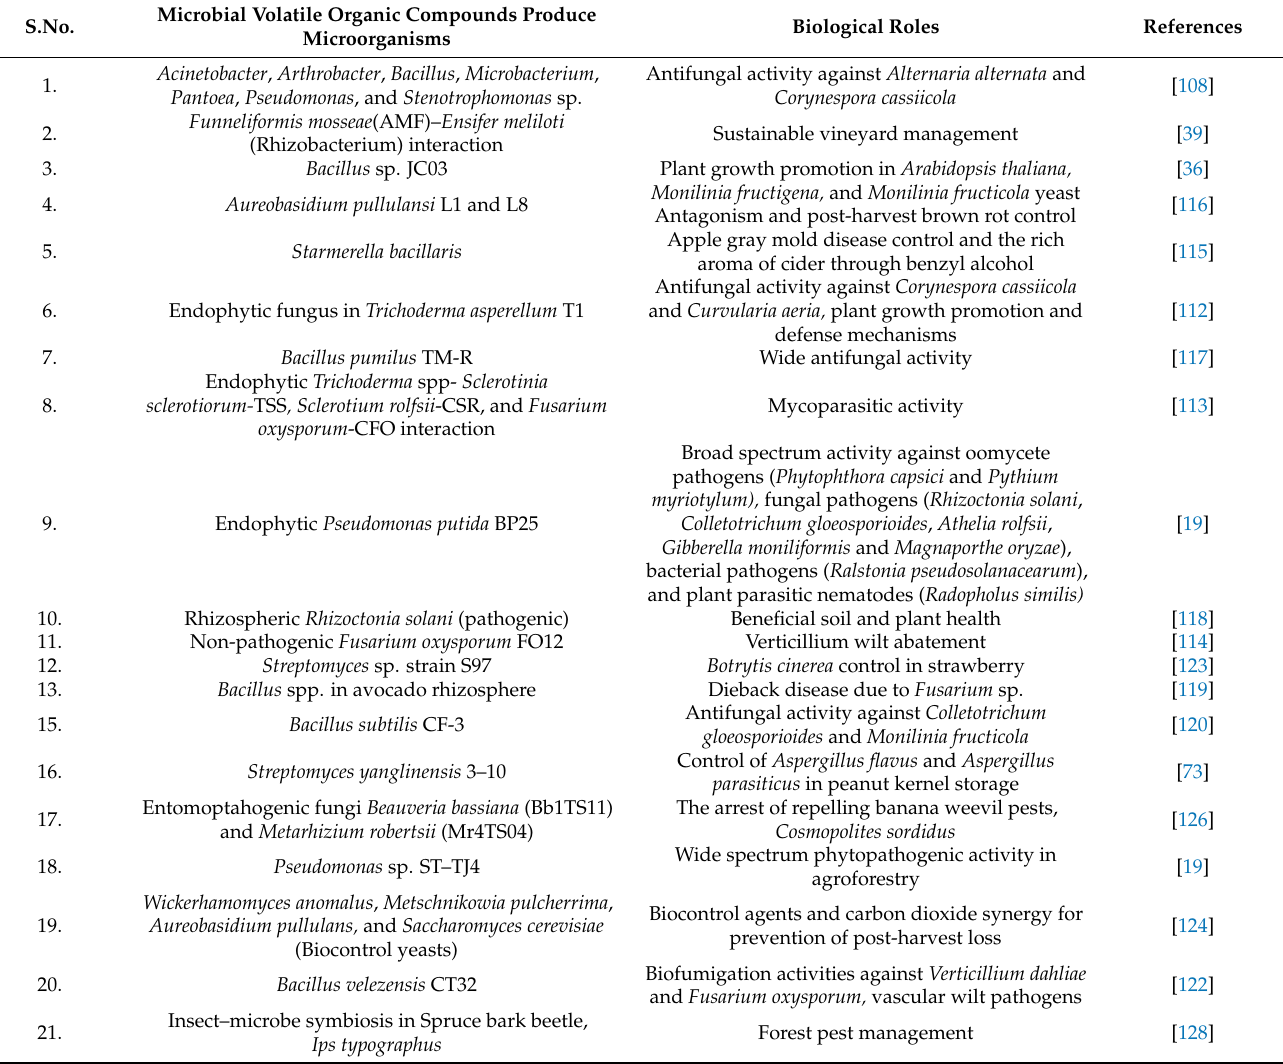
Table 2. Microbial volatile organic compounds and their potential biological